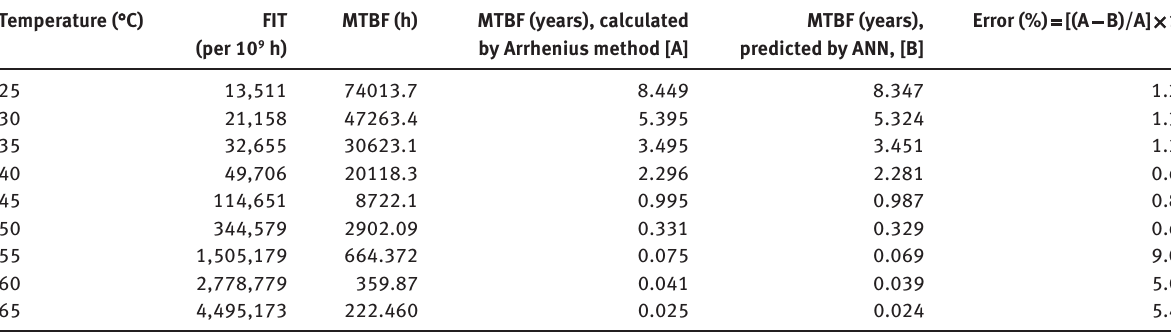
Table 3: MTBF calculations and error